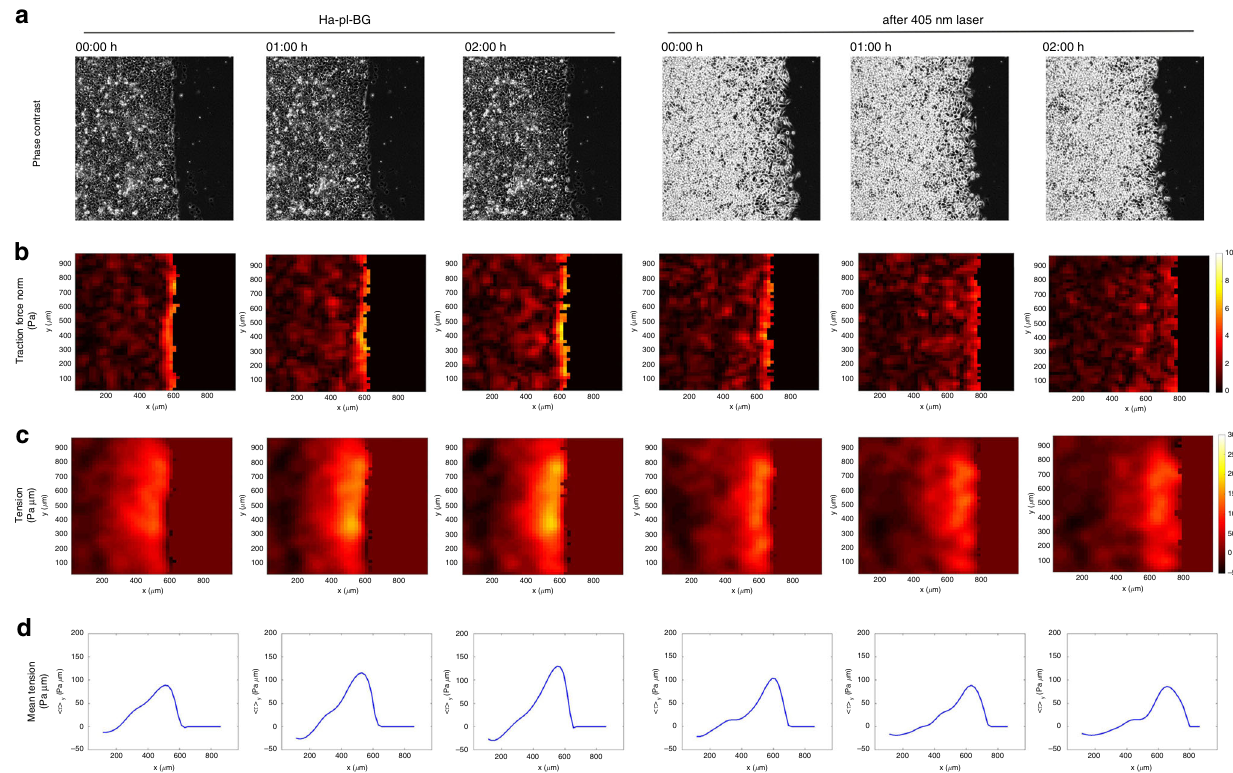
Fig. 6 LInDA changes the internal tension of epithelial monolayers. a Phase contrast images of migrating cells treated with Ha-pl-BG. Shown are three selected time points from a continuous time lapse recording before (Ha-pl-BG) and after cleaving the dimerizer (after 405 nm laser). b Heat maps of traction force norm in the same spatial domain as a . Traction Force Microscopy analysis of migrating cells shows that the norms of traction forces are gradually reduced after photocleavage of the Ha-pl-BG dimerizer. c , d Internal stresses are estimated applying Bayesian Inversion Stress Microscopy (BISM) on traction force data. BISM analysis shows that the monolayer tension is also reduced after exposure of the migrating monolayer to UV light pulse. c Heat maps of the mechanical tension in the same spatial domain as in a . d 1D pro fi le of the tension averaged over the direction parallel to the moving cadherins are not dimerized. However, in presence of Ha-pl-TMP observation. Its estimate is 50.8 ± 6.4 Pa µm ( fi eld of view n = 5) dimerizer, the GFP signal of DHFR-cyto translocates to the cell for 2D migrating dimerized epithelial layer and it drops to 27.5 ± membrane and colocalizes with α -catenin; further, actin fi laments 6.7 Pa µm ( n = 3) after photocleavage of the dimerizer and become more evident (Supplementary Fig. 8 second row). Fol- lowing photocleavage of the dimerizer, the cytosolic tail of E-cadherin accumulates in the cytoplasm, whereas α -catenin and actin are still present at cell junctions and cells do not completely dissociate from each other (Supplementary Fig. 8 third row). This shows that LInDA acts speci fi cally on the targeted E-cadherin without disrupting the functionality of other cadherin-catenin complexes.